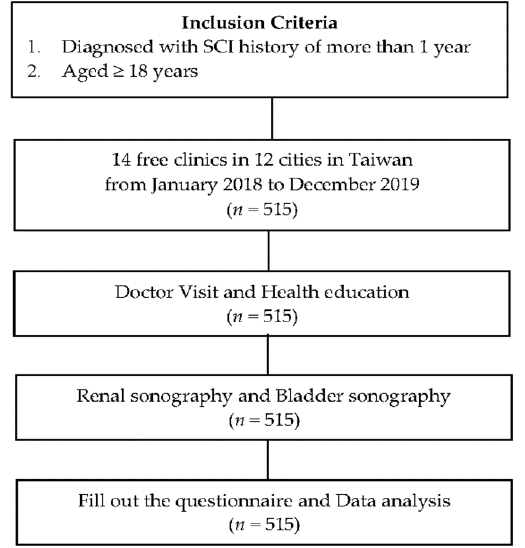
Figure 1. The flow diagram of the